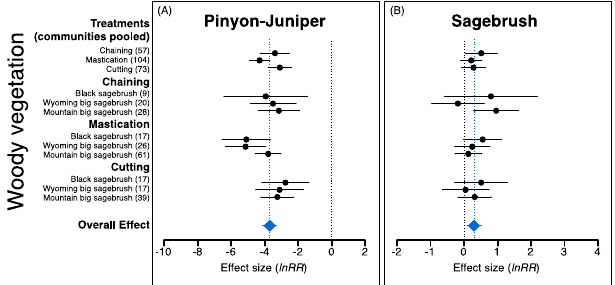
Figure 3. Mean effect sizes and 95% confidence intervals ( lnRR ; pre vs. posttreatment cover) for pinyon-juniper ( A ) and sagebrush ( B ) responses following pinyon–juniper reduction in three sagebrush